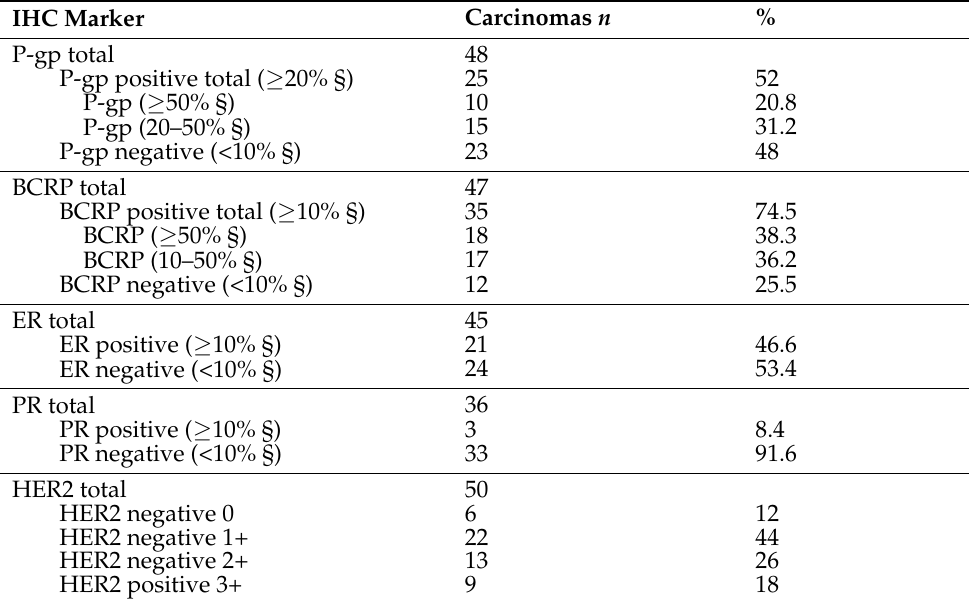
Table 2. Immunohistochemical results: Percentage and number of samples scored as positive and negative for P-gp, BCRP, ER, PR, HER2, CK5/6, EGFR and Ki67 in the